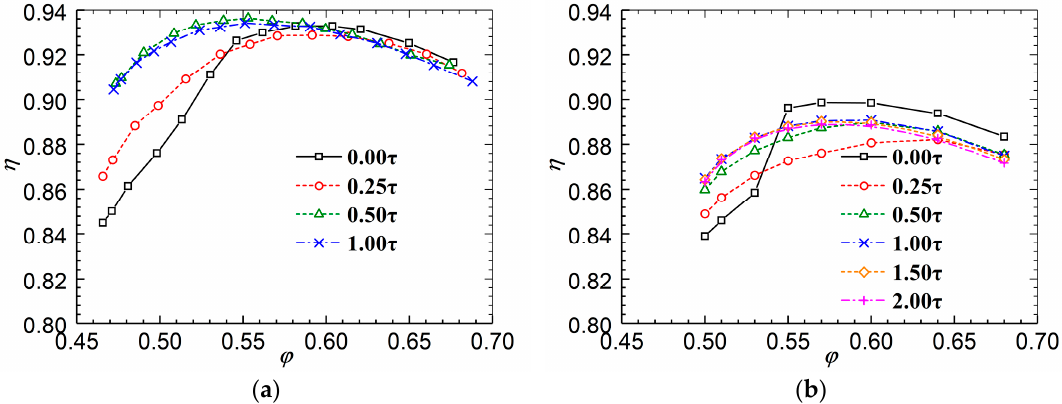
Figure 4. Characteristics of compressor efficiency. ( a ) Experimental results; ( b ) CFD results.